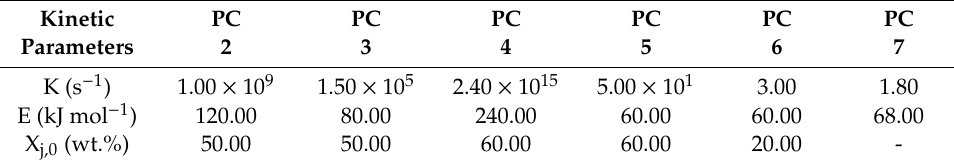
Table 4. Upper bonds of the pseudocomponents (PC).